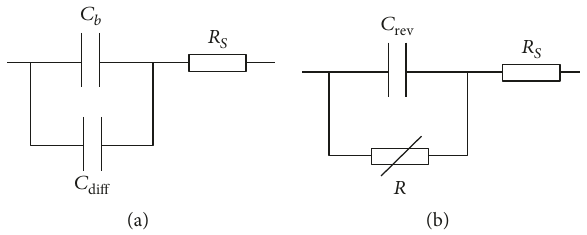
Figure 7: Simplified equivalent circuit of p-i-n junction for direct connection (a) and reverse connection